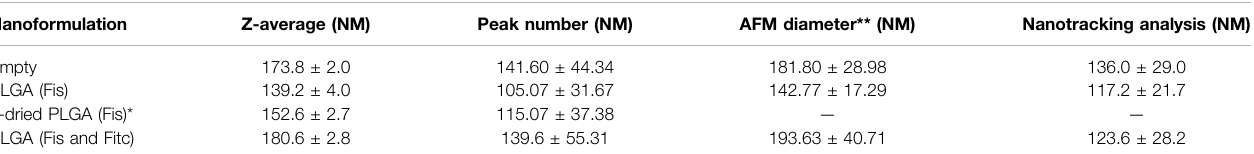
TABLE 2 | DLS, AFM, and nanotracking analysis data of empty, PLGA (Fis), freeze-dried PLGA (Fis)*, and PLGA (Fis and Fitc) nanoparticles. The statistical analysis was performed over a population > major than 30 using SPIP statistical tool. Nanoformulation